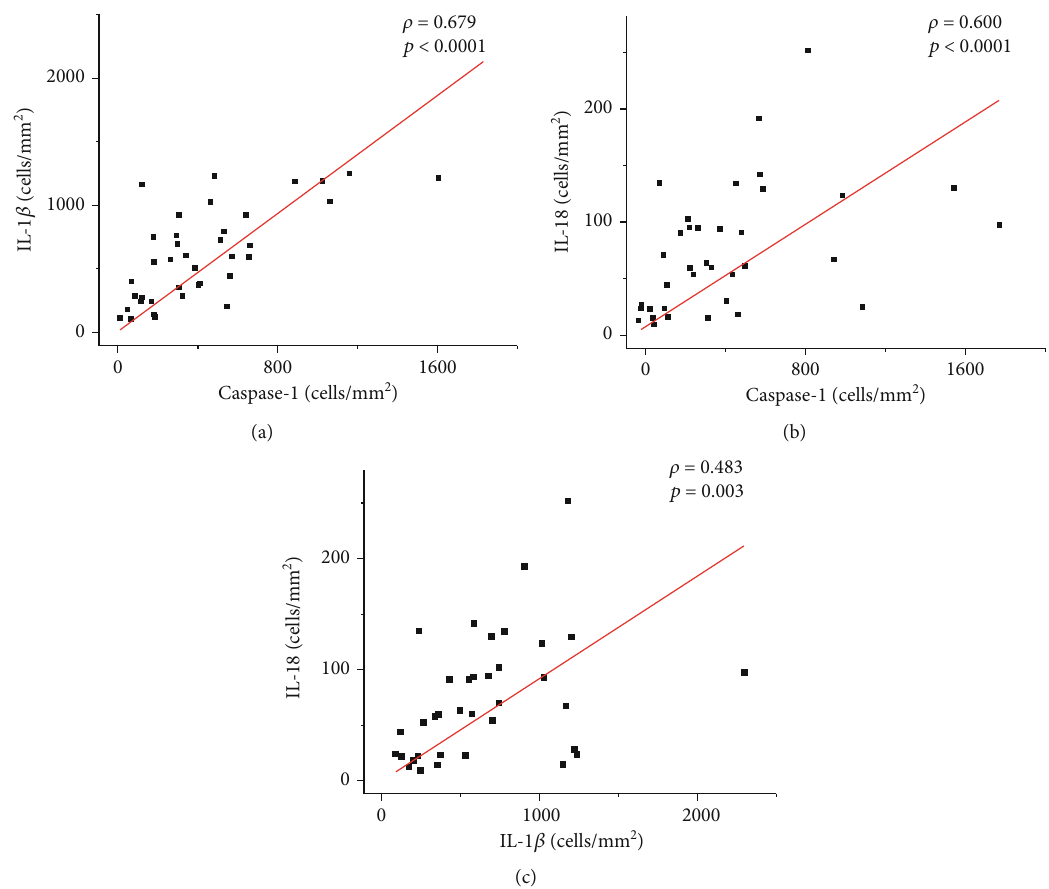
Figure 6: Graphs showing the correlation between the cellular density of Caspase-1 + cells with IL-1 β + cells (a) and IL-18 + cells (b). The positive correlation between IL-1 β + cells and IL-18 + cells (c). The value of ρ is Spearman ’ s correlation coe ffi cient, and p is the p value. The red line indicates a positive